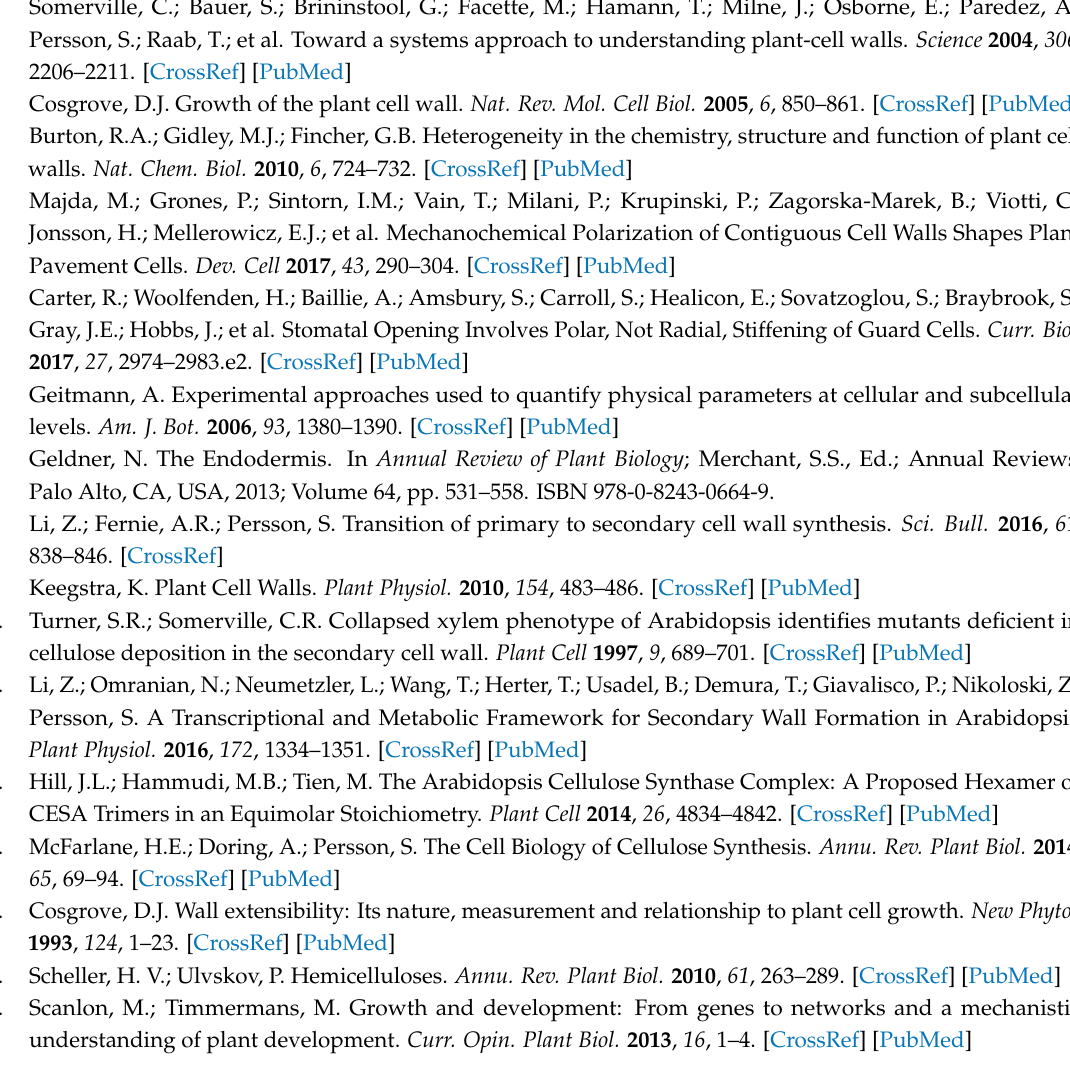
Table S1: Experimentally supported phosphorylation sites identified on CESA and CSC-associated proteins, Table S2: Experimentally supported phosphorylation residues on Arabidopsis CSL family